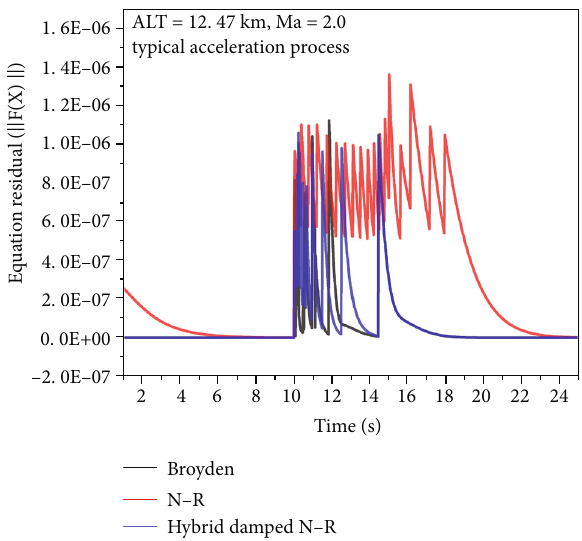
Figure 9: The variation pattern of equation residual during the acceleration process. Figure